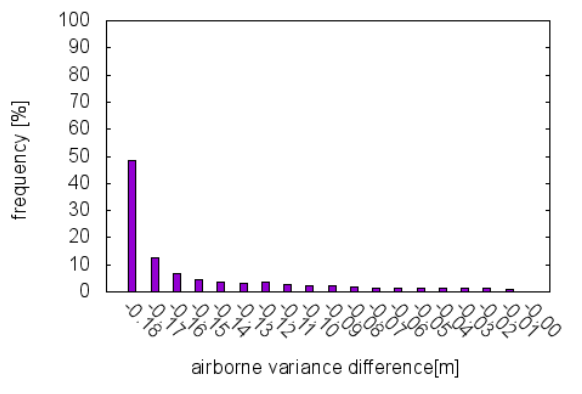
Figure 4. Histogram of differences in airborne variance calculated by RTKLIB and magicGemini